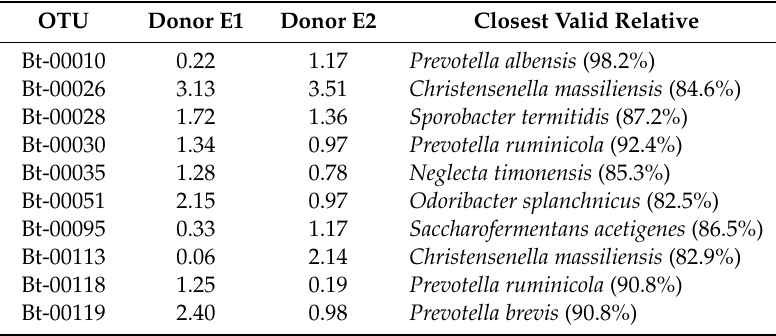
Table 1. Relative abundance of the ten most highly represented ruminal bacterial operational taxonomic units (OTUs) from the rumen fluid donors used in this study (D0). Abundance is presented as a percentage (%) of the total number of quality-filtered reads per sample. OTU Donor